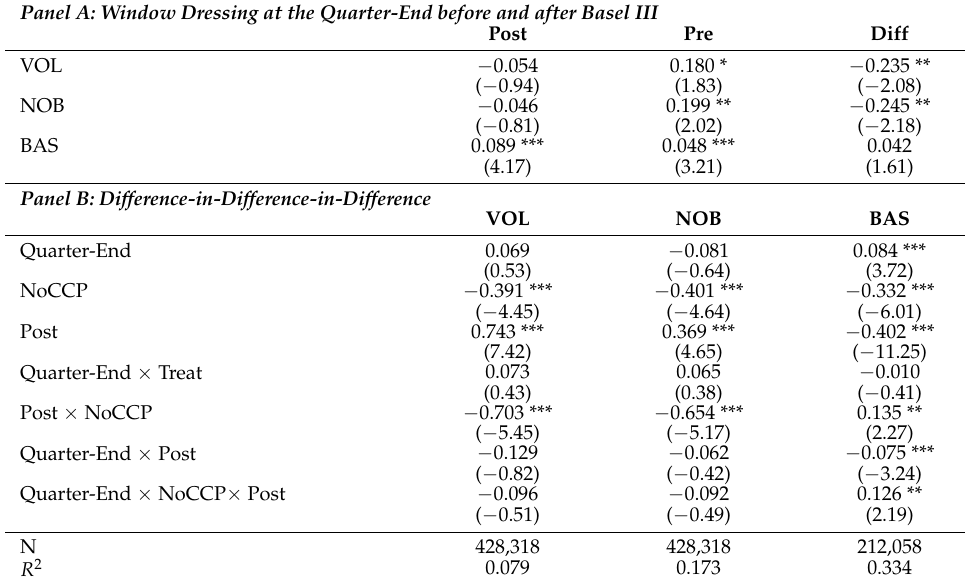
Table 11. Window dressing at the quarter-end and Basel III. Panel A: Window Dressing at the Quarter-End before and after Basel III